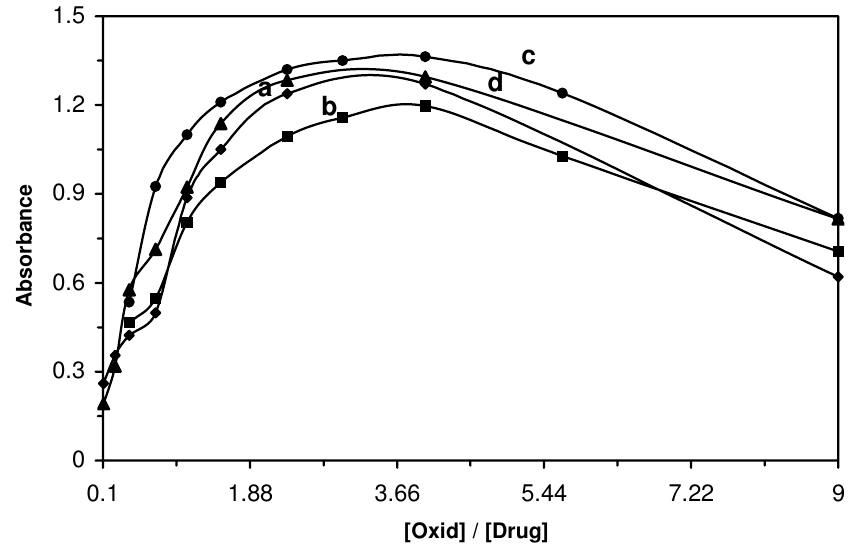
Fig. 3 Continuous variations graph for the reaction between 5.0 × 10 − 4 M gentamicin and 5.0 × 10 − 4 M KMnO with: (a) AM (b) AO (c) Indigo and (d) 4